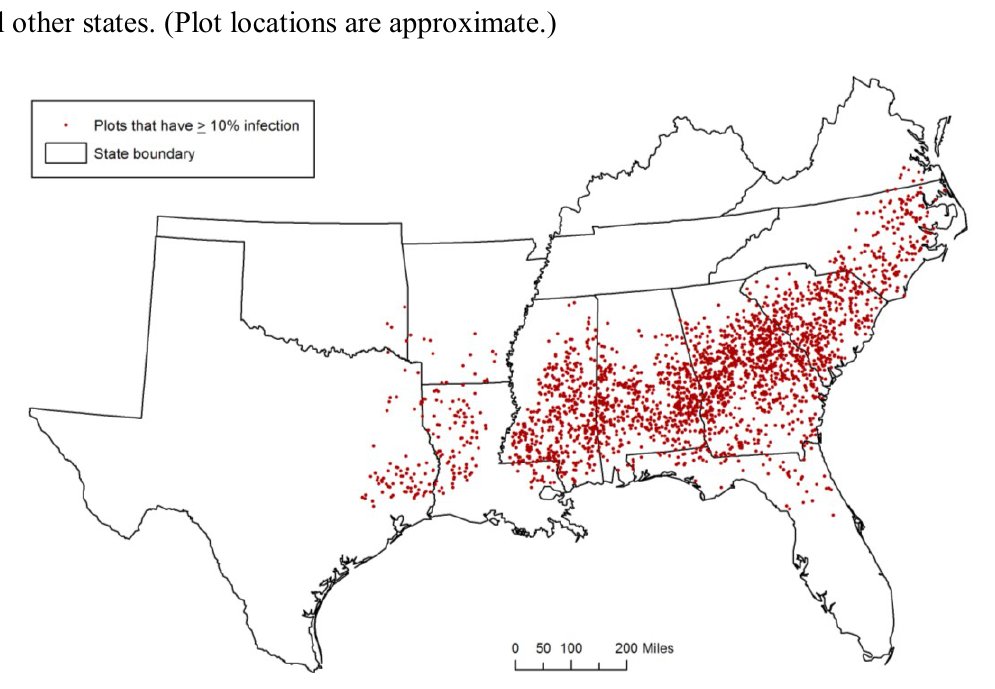
Figure 2. Location of Forest Inventory and Analysis (FIA) plots with the slash pine forest type and >10% fusiform rust infection on trees at least 5.0 inches diameter at breast height. Estimates of infection are based on FIA inventory year 2010 in Louisiana and 2011 in all other states. (Plot locations are